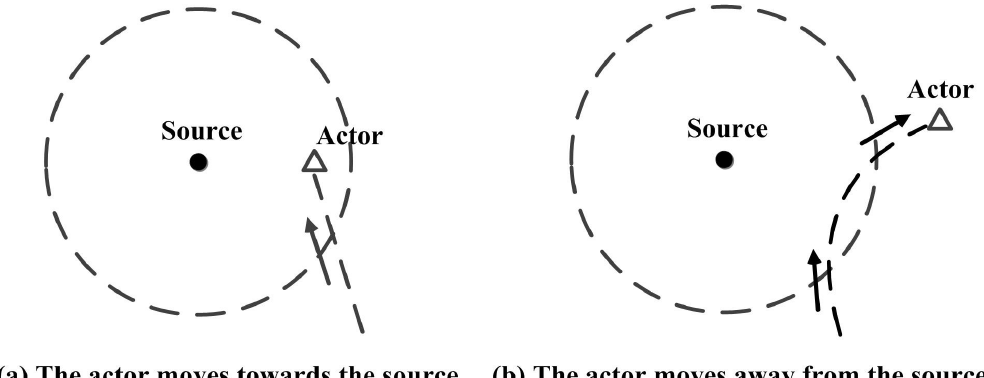
Figure 2. The scenarios that the packet discovers the